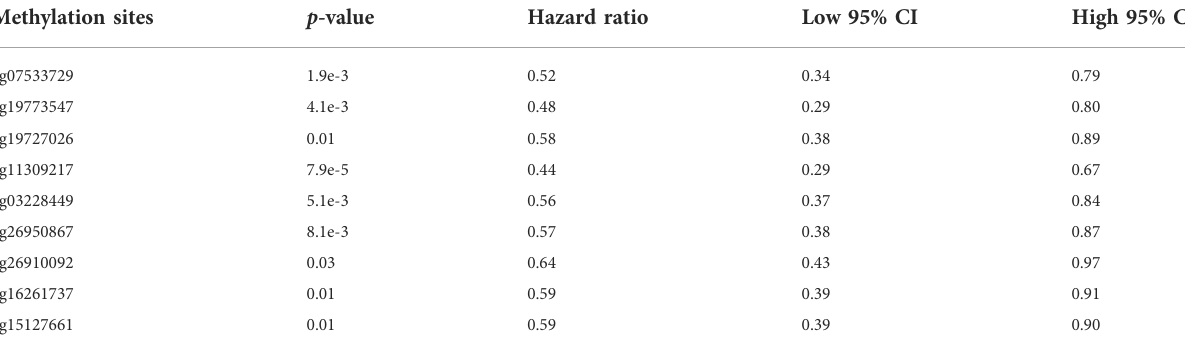
TABLE 5 Summary of the Kaplan-Meier curve data for the nine hyper-methylation sites of FN1 in breast cancer. Methylation